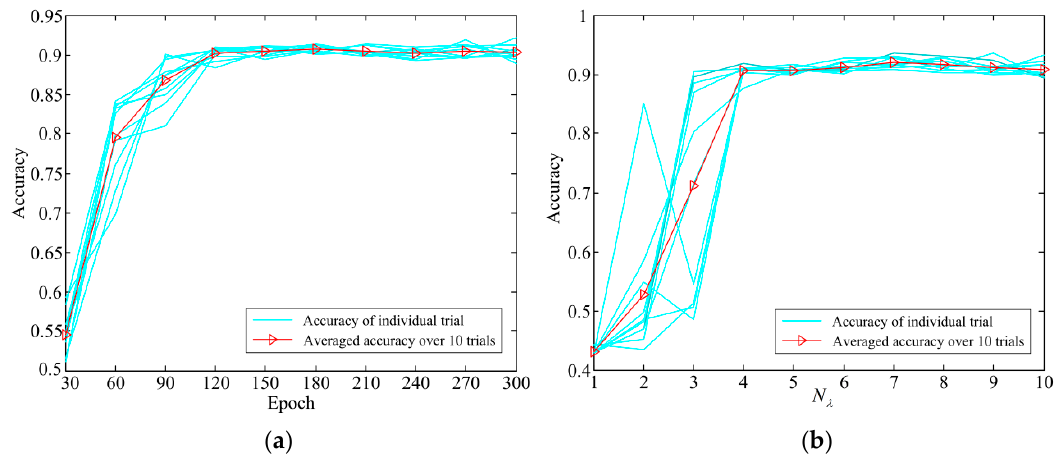
Figure 9. Parameters affecting the diagnosis accuracy: ( a ) epochs, ( b ) N λ .